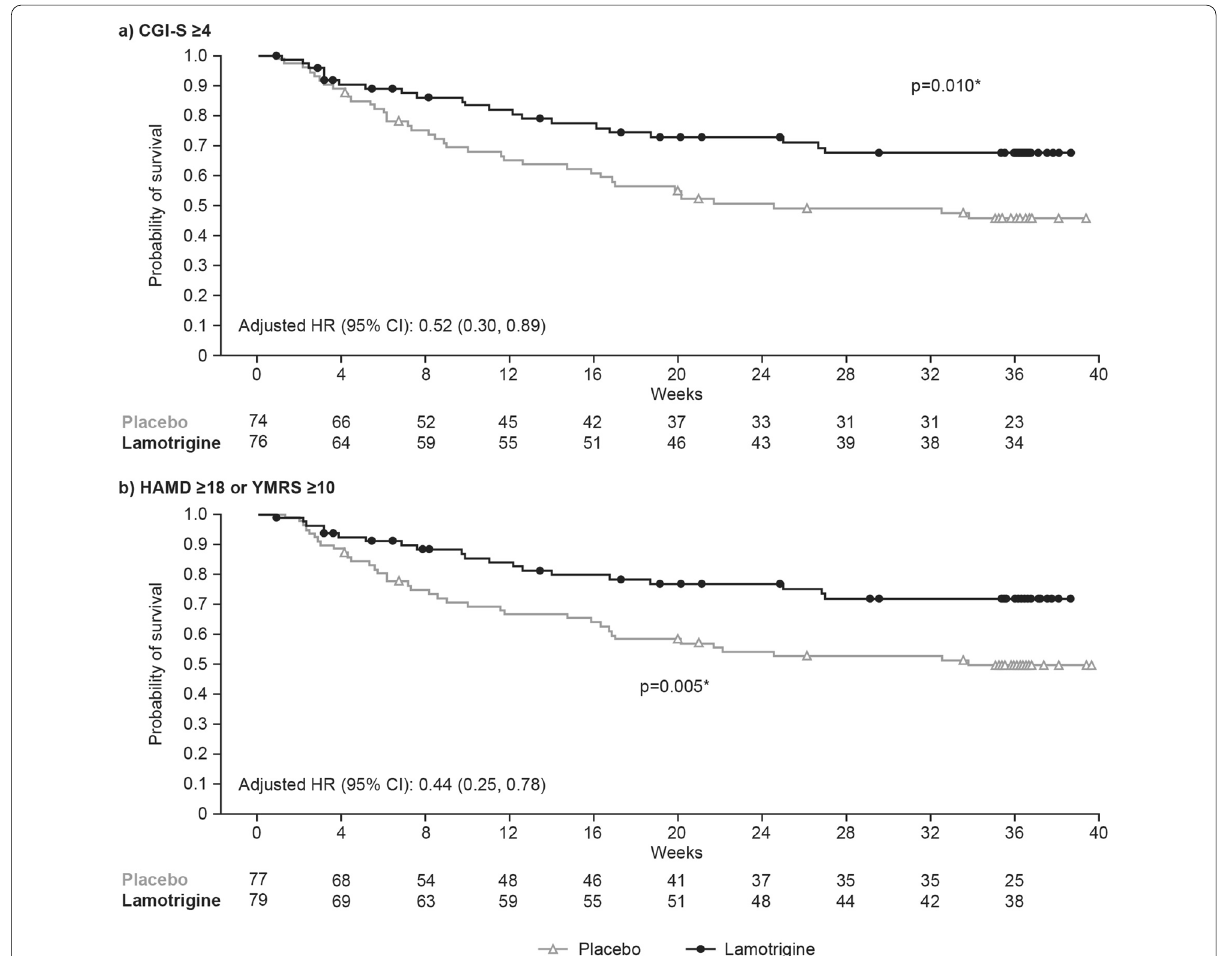
Fig. 4 Kaplan–Meier survival estimates for TIME in patients with moderate/severe baseline mood symptoms. *The p values were calculated using the log‑rank test and is for the PBO versus LTG comparison. Marks represent censored events. Estimates are for the RD FAP (excluding patients without baseline CGI‑S or HAMD/YMRS scores). CGI‑S, Clinical Global Impressions of Severity; FAP, full analysis population; HAMD, Hamilton Depression Rating Scale; LTG, Lamotrigine; PBO, Placebo; RD, randomised double‑blind; TIME, time to intervention for a mood episode; YMRS,